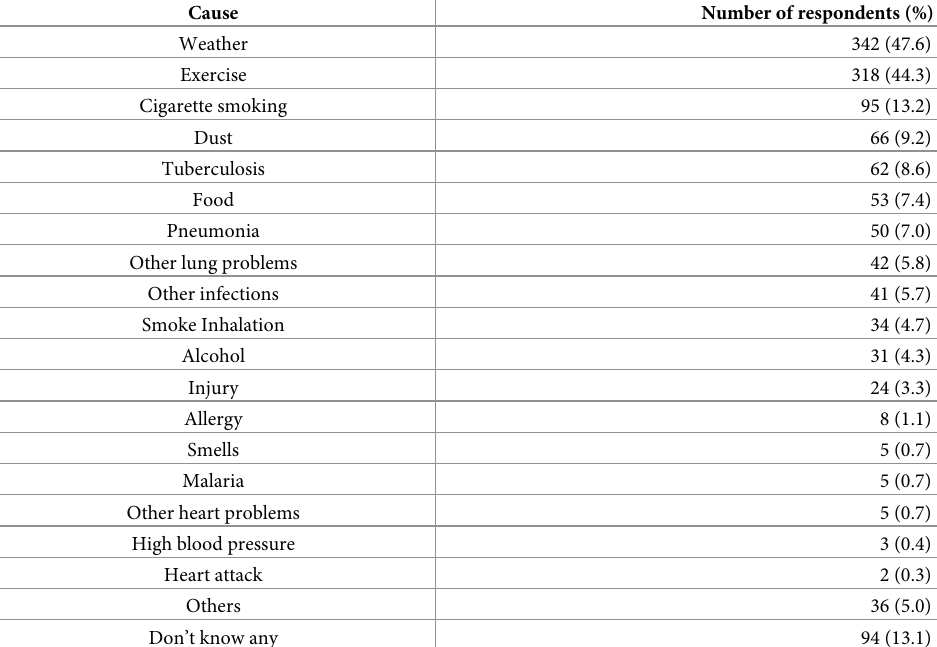
Table 2. Possible causes of chest pain in an adult identified by adult residents of northern Tanzania, 2018 (N = 718).